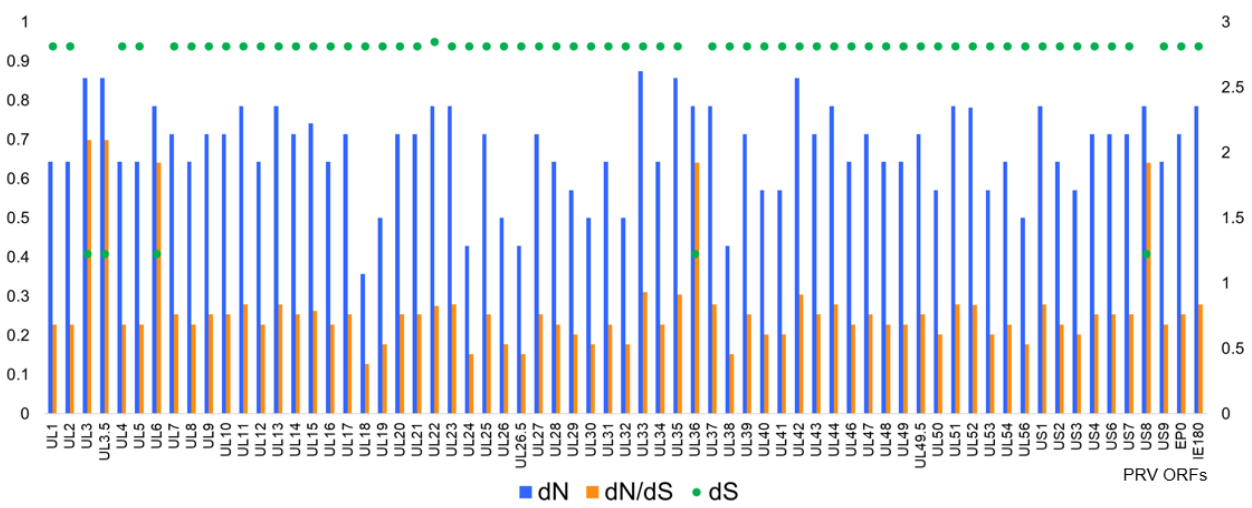
Figure 5. Selection pressure analysis. Selection pressure of each ORF of PRV was analyzed. ORF sequences were extracted from each annotated genome. By using FUBAR in the Datamonkey web server, nonsynonymous substitutions per nonsynonymous site (dN), synonymous substitutions per synonymous site (dS), and the dN/dS ratio of each ORF were calculated. The result is plotted as a bar graph. The dN and dN/dS ratio read the major y -axis at the left side, and dS takes the minor y -axis at the right side.